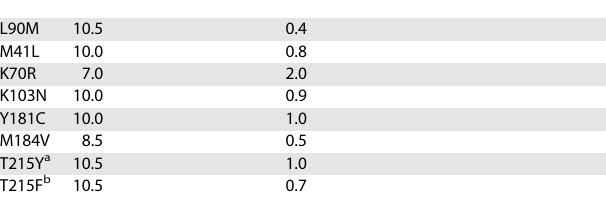
Table 2. Real-Time PCR Resistance Mutation Assay Cutoffs and Relative Sensitivities for Clinical Sample Testing Established Using Drug-Resistant and Pre-ART Wild-Type Clinical Samples [19]